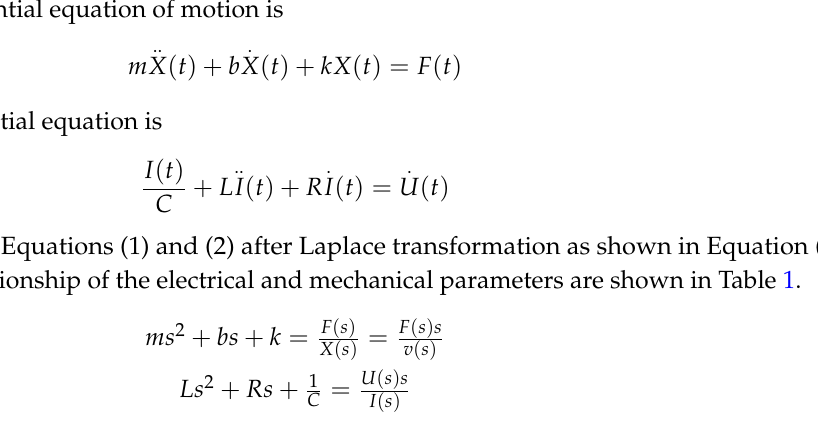
Table 1. The corresponding relationship of the electrical and mechanical parameters.